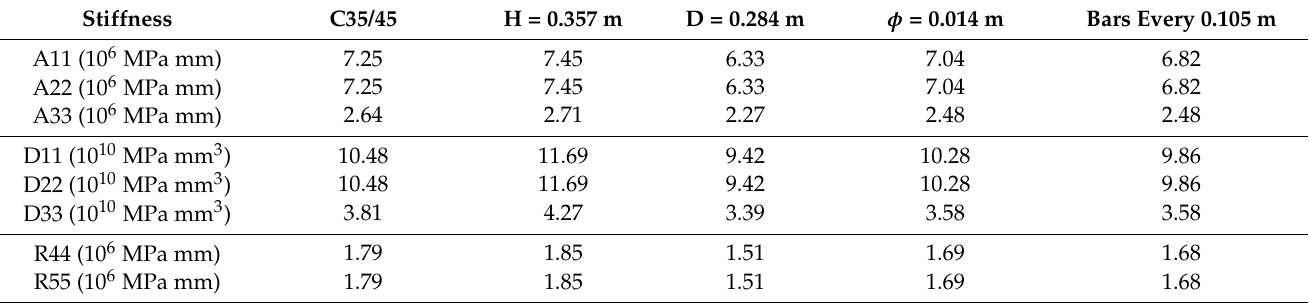
Table 4. Stiffness for RVE BD340 in case of increasing the value of individual cross-section parameters.